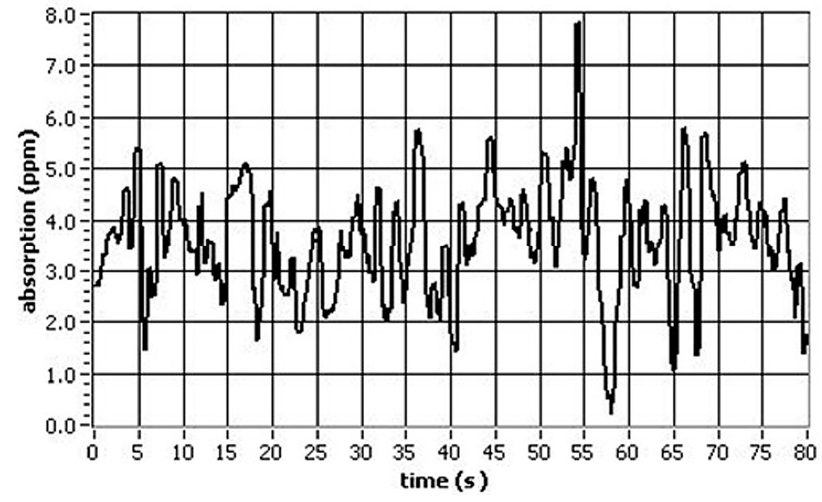
Figure 5. Absorption of the ultra-high reflector.